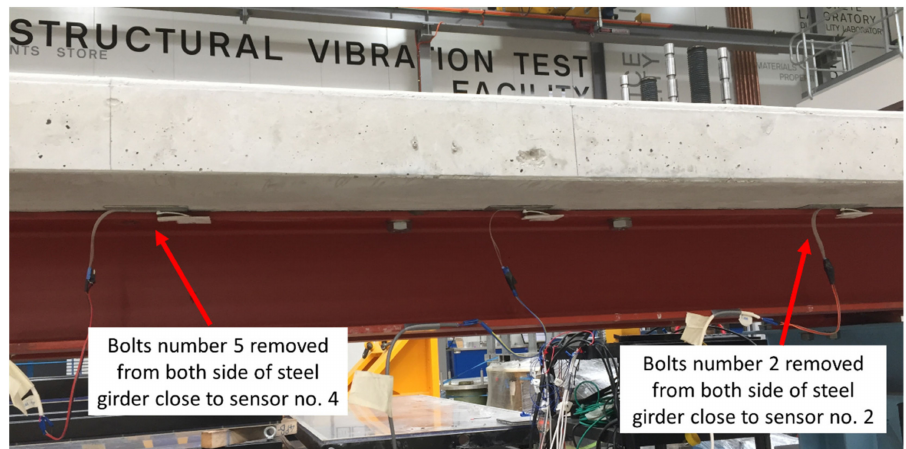
Figure 13. Second and fifth rows of bolts are removed from the inner and outer sides to define double damage.